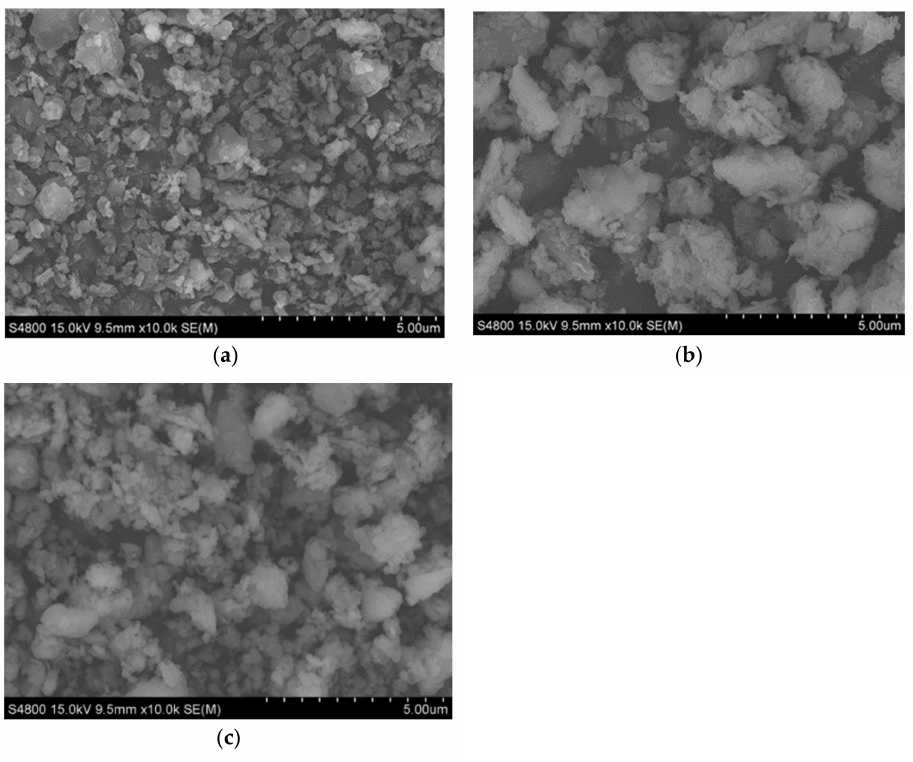
Figure 1. SEM images of different adsorbents: ( a ) kaolin; ( b ) kaolin-sodium bentonite; ( c ) kaolin- organic bentonite.